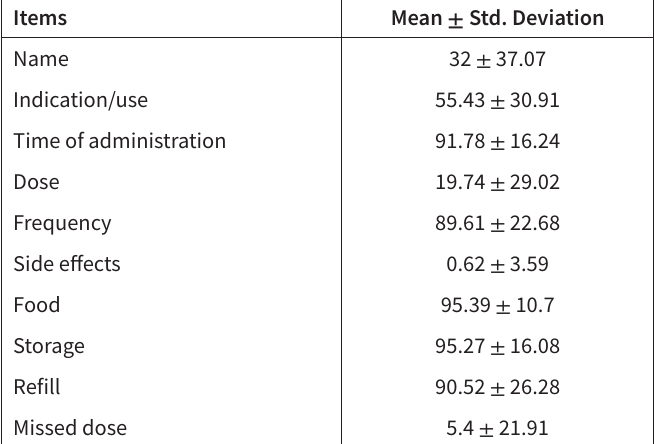
Table 3. Medication Knowledge Score of HD